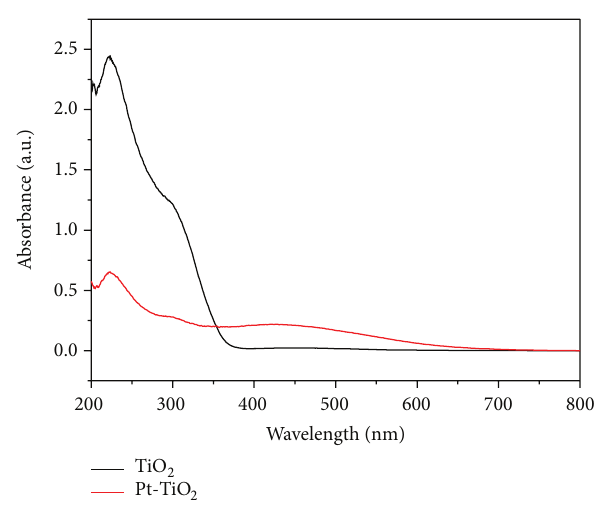
Figure 3: UV-vis DRS spectra of TiO 2 and Pt-TiO 2 nanosheet films.